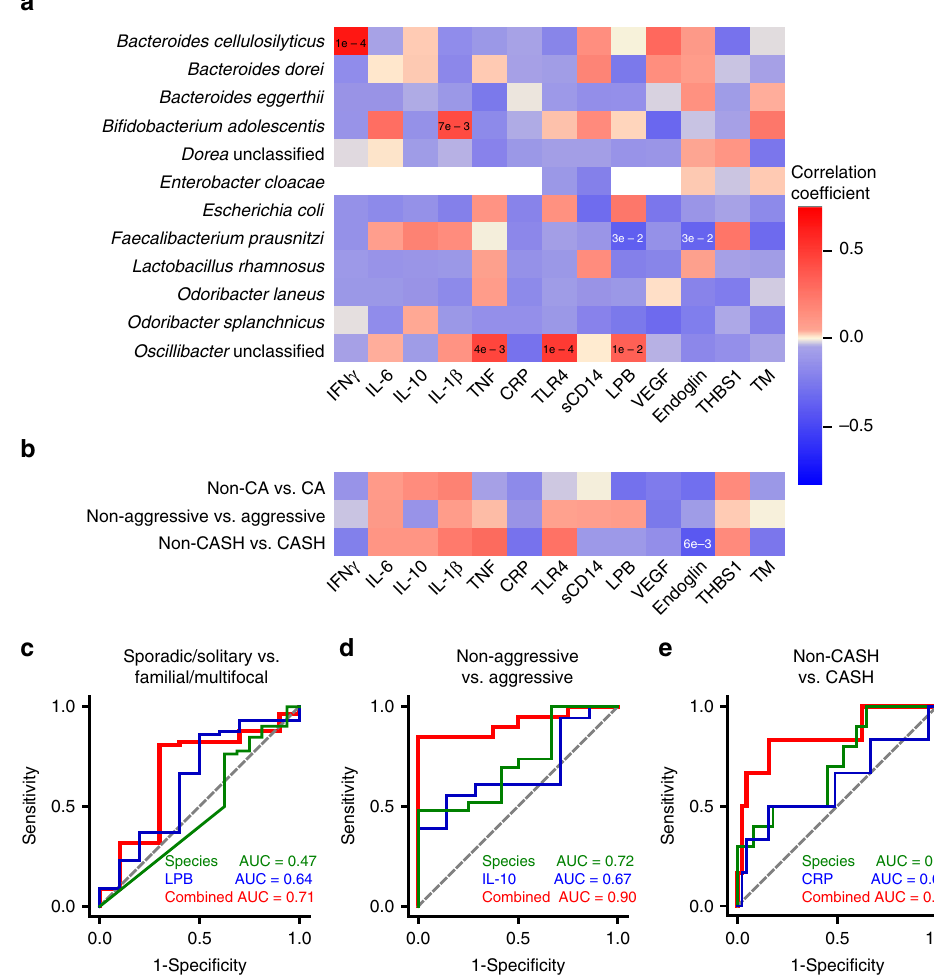
Fig. 4 Plasma and fecal microbiome as CA biomarkers. a Correlation between individual bacterial species and circulating factors. Correlation between species identi fi ed by multi-variate differential abundance and random forest analyses (Figs. 1 and 3, Supplementary Fig. 2) and individual plasma biomarkers. Degree of correlation is color coded (also see Supplementary Table 1, Pearson ’ s correlation testing; red: positive correlation; blue: negative correlation). b Correlation between combination of species identi fi ed based on clinical questions and circulating factors. Correlation between combination of bacterial species identi fi ed (in Figs. 1 and 3, Supplementary Fig. 2) and individual plasma biomarkers. Degree of correlation is color coded (also see Supplementary Table 1, Pearson ’ s correlation testing, red: positive correlation, blue: negative correlation). c – e Comparison of best ROC curve determined by combination of bacterial species identi fi ed in Fig. 3 and Supplementary Fig. 2, individual circulating factors, and bacterial species and individual circulating factors. c Distinction between sporadic/solitary and familial/multifocal CA patients (green: bacterial species identi fi ed in Supplementary Fig. 2 ( B. dorei ), blue: LPB, red: combined bacterial species and LPB). d Distinction between non-aggressive and aggressive CA patients (green: bacterial species identi fi ed in Fig. 3b, c, blue: IL-10, red: combined bacterial species and IL-10). e Distinction between non-CASH and CASH patients (CASH patient, green: bacterial species identi fi ed in Fig. 3g, h, blue: CRP, red: combined bacterial species and CRP). IFN γ interferon- γ , TNF tumor necrosis factor; CRP C-reactive protein, TLR4 toll-like receptor 4, VEGF vascular endothelial growth factor, THBS1 thrombospondin 1, TM